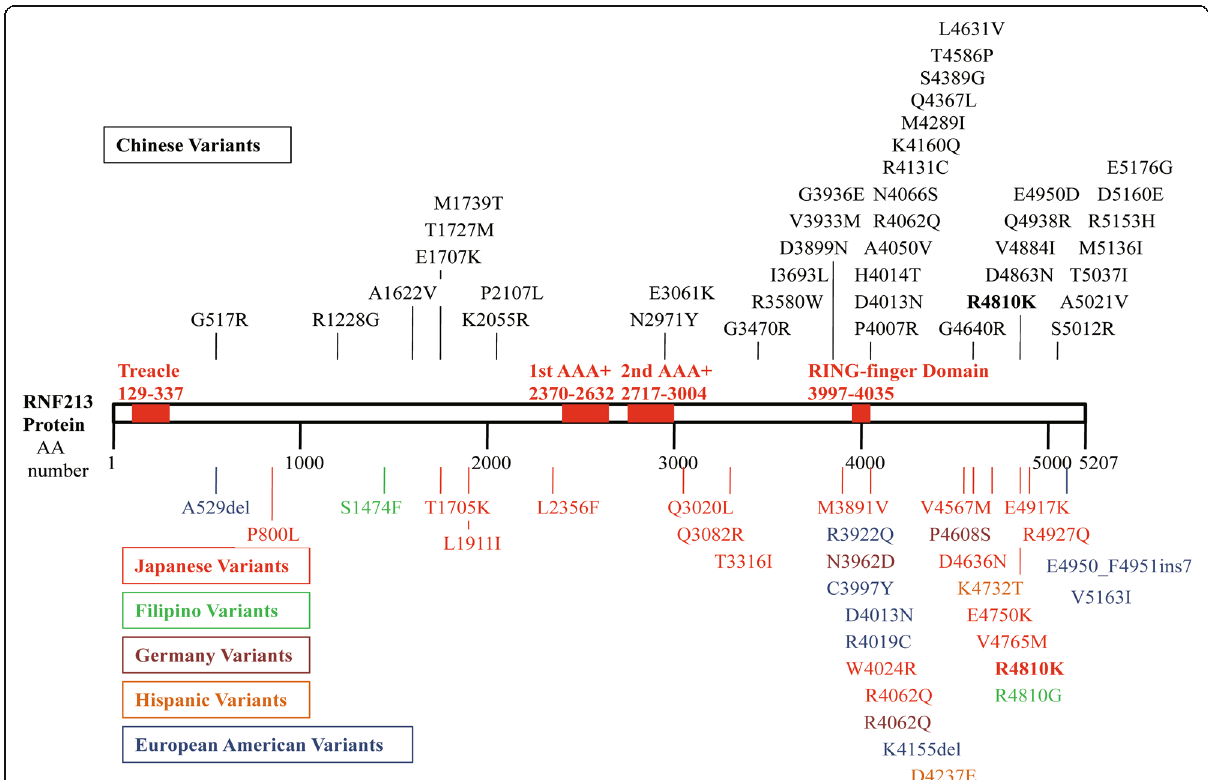
Fig. 6 Other rare variants of RNF213 identified in MMD individuals. The figure was adapted from Cecchi et al. [14] and Koizumi et al. [29]. Variants identified in different populations are marked in different colors respectively. AA, amino acid; AAA+, ATPase associated with diverse cellular activities domain. The bold-styled variant mean the most robust one associated with